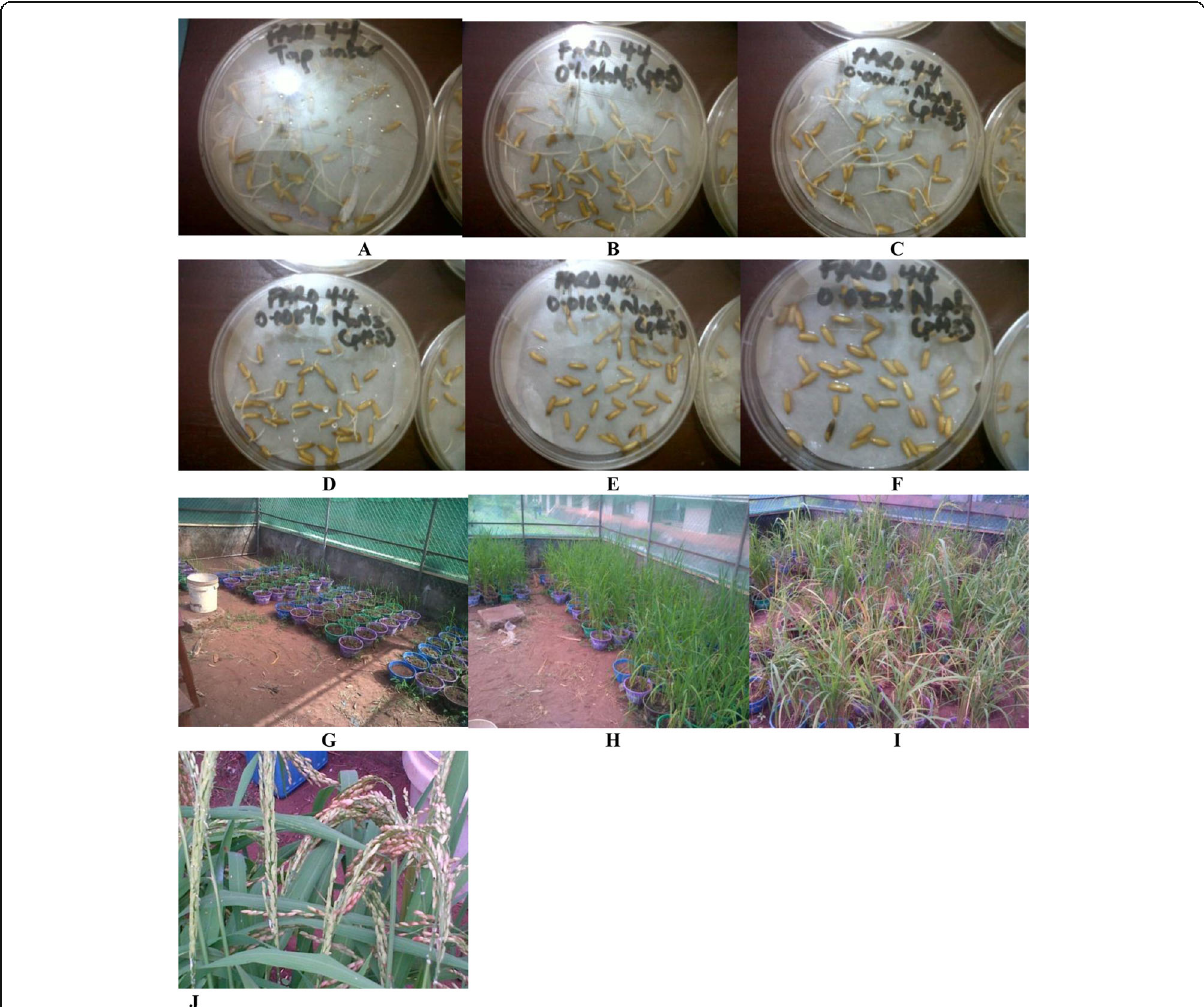
Fig. 4 Germination and screen house experiments. a FARO-44 (control) at 2 DAP. b FARO-44 (0% NaN 3 ) at 2 DAP. c FARO-44 (0.004% NaN 3 ) at 2 DAP. d FARO-44 (0.008% NaN 3 ) at 2 DAP. e FARO-44 (0.016% NaN 3 ) at 2 DAP. f FARO-44 (0.032% NaN 3 ) at 2 DAP. g Rice plants at 2 WAP. h Rice plants at 12 WAP. i Mature rice plants. j Rice